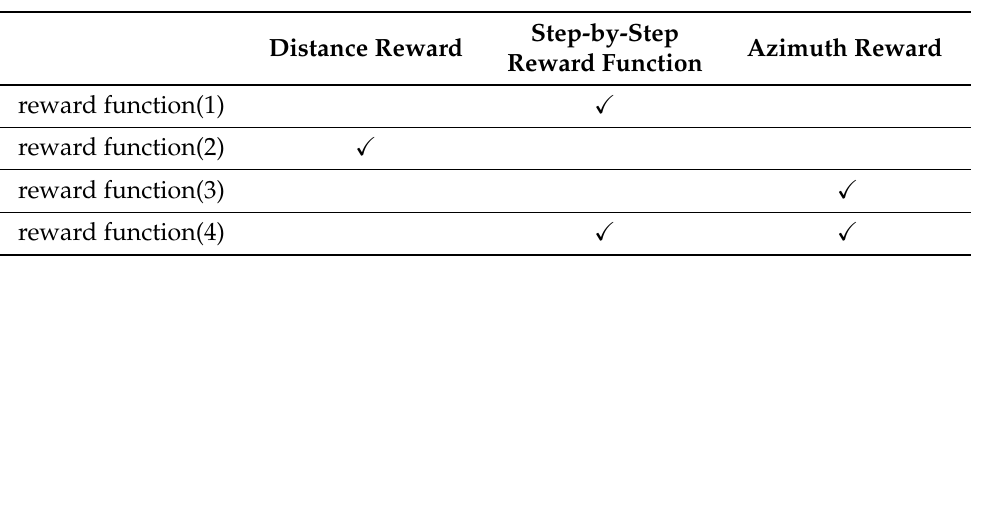
Table 5. Four reward